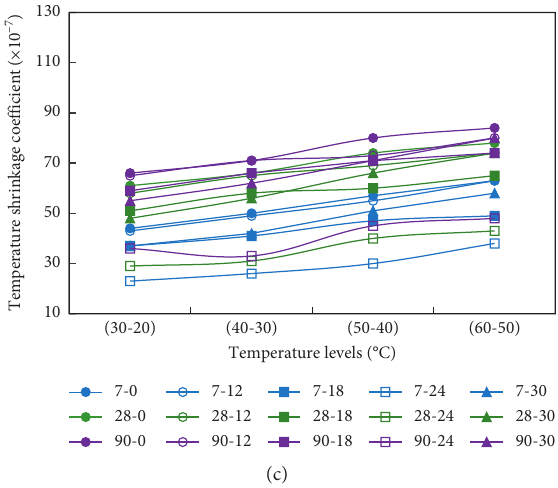
Figure 18: Trend chart of TSC of PFRC with different temperature levels: (a) cement content of 3.2%, (b) cement content of 3.6%, and (c) cement content of 4.0%.